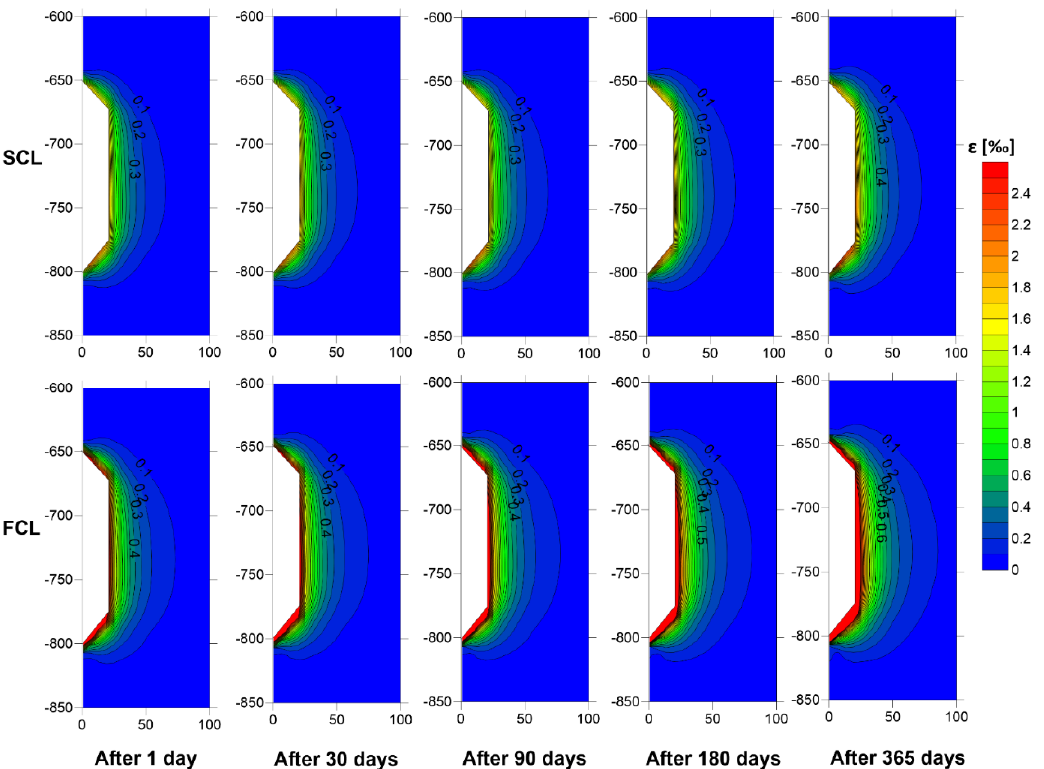
Figure 7. Comparison of the deformations of the cavern wall at the end of 1, 30, 90, 180 and 365 days of CAES cavern operation for the slow- (SCL) and fast-creep law (FCL) models, and the temperature changes in the rock mass were also implemented.